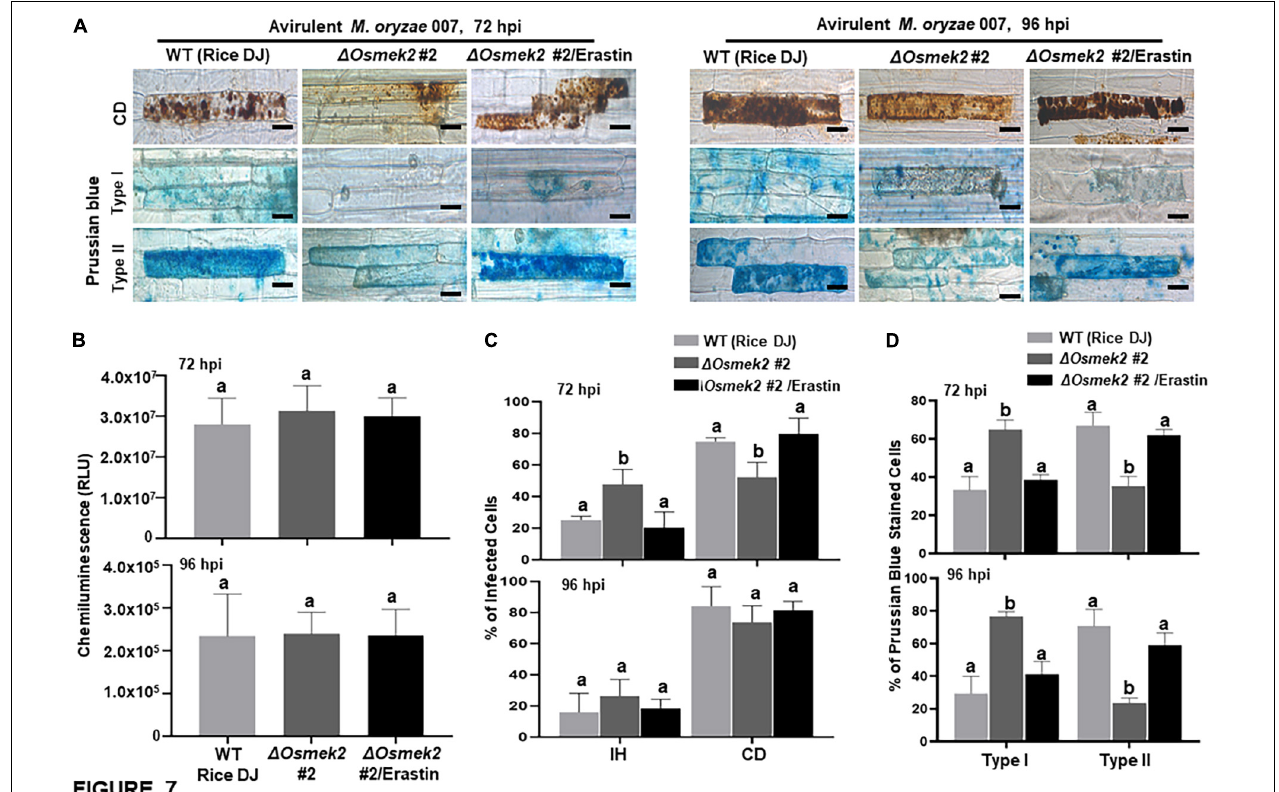
FIGURE 7 | Disease-related cell death is ROS-dependent and iron-independent in the compatible (cid:49) Osmek2 – Magnaporthe oryzae interaction. (cid:49) Osmek2 #2 leaf sheaths were inoculated with conidial suspensions (4 × 10 5 conidia mL − 1 ) of M. oryzae 007 containing 10 µ M erastin. M. oryzae 007 infection induced disease-related cell death, but (cid:49) Osmek2 #2 leaf sheath cells did not accumulate ferric ions (Fe 3 + ) at 96 h after inoculation. (A) Erastin treatment induces cell death and ferric ion (Fe 3 + ) accumulation in (cid:49) Osmek2 #2 leaf sheath cells during avirulent M. oryzae 007 infection. Prussian blue (blue color) staining shows ferric ion accumulation in rice cells. The images are representative of different leaf sheath samples from three independent experiments. Scale bars = 20 µ m. (B) Quantification of ROS accumulation in leaf sheath cells. ROS quantities were monitored using a GloMax R (cid:13) 96 Microplate Luminometer (Promega). Values are means ± SD of total relative luminescent units (RLU) ( n = 10). (C) Quantification of infected cell phenotypes in rice leaf sheaths. Results are presented as mean values ± SD; n = 4 leaf sheaths from different plants. (D) Quantification of Prussian blue-stained cells. Prussian blue-stained cells were categorized into two phenotypes: Type I, cells that contain invasive hyphae (IH) but are weakly or not Prussian blue-stained; and Type II, strongly Prussian blue-stained with only a few poor hyphae. Images were taken using a fluorescence microscope (Zeiss equipped with Axioplan 2). Experiments were repeated three times with similar results. Results are presented as means ± SD; n = 4 leaf sheaths. Different letters above the bars indicate significantly different means ( P < 0.05), as analyzed by Fisher’s protected LSD test. IH, invasive hyphae; CD, cell death; BF, bright field; GF, green fluorescence; hpi, hours post-inoculation.